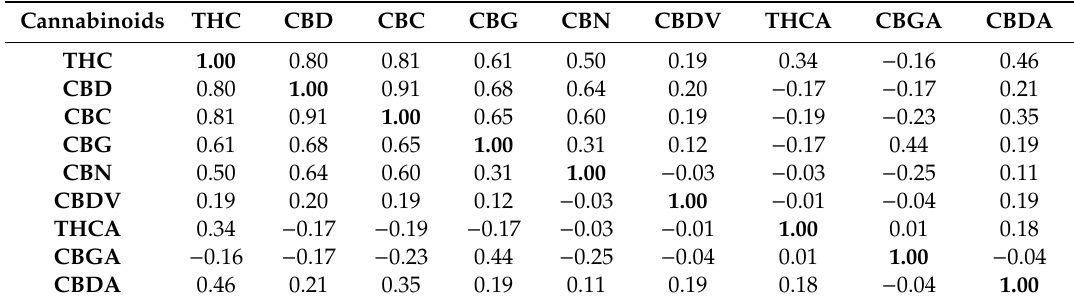
Table 2. Correlation matrix (Pearson coe ffi cients) between the nine cannabinoids variables (THC, CBD, CBC, CBG, CBN, CBDV, THCA CBGA and CBDA). The correlation coe ffi cients were calculated using the relative concentrations of cannabinoids in the 161 hemp samples sold by the four Italian